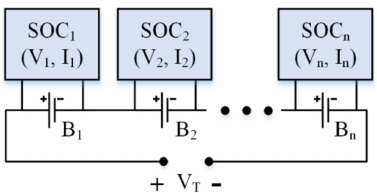
Figure 3. State of charge (SOC) estimation maneuver from